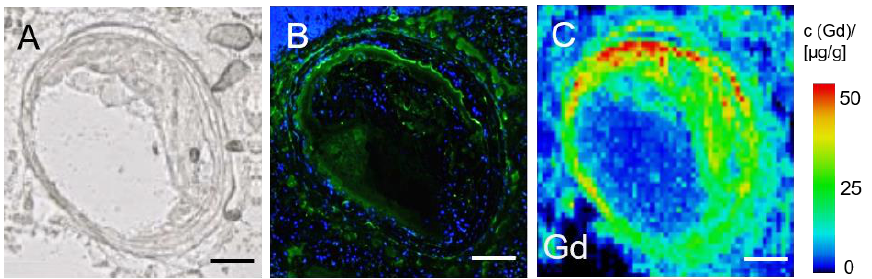
Figure 6. LA-ICP-MS analysis of gadolinium distribution in an atherosclerotic plaque. ( A ) Native cryosection of the brachiocephalic artery of an ApoE -/- -mouse after 2 months of HFD. ( B ) Serum albumin-specific immunohistological staining of a serial section. ( C ) LA-ICP-MS showing gadolinium distribution across the brachiocephalic wall in a serial section of the same sample and a clear colocaliaztion of Gd and areas positive for albumin staining ( A ). The scale displays 100 µm.